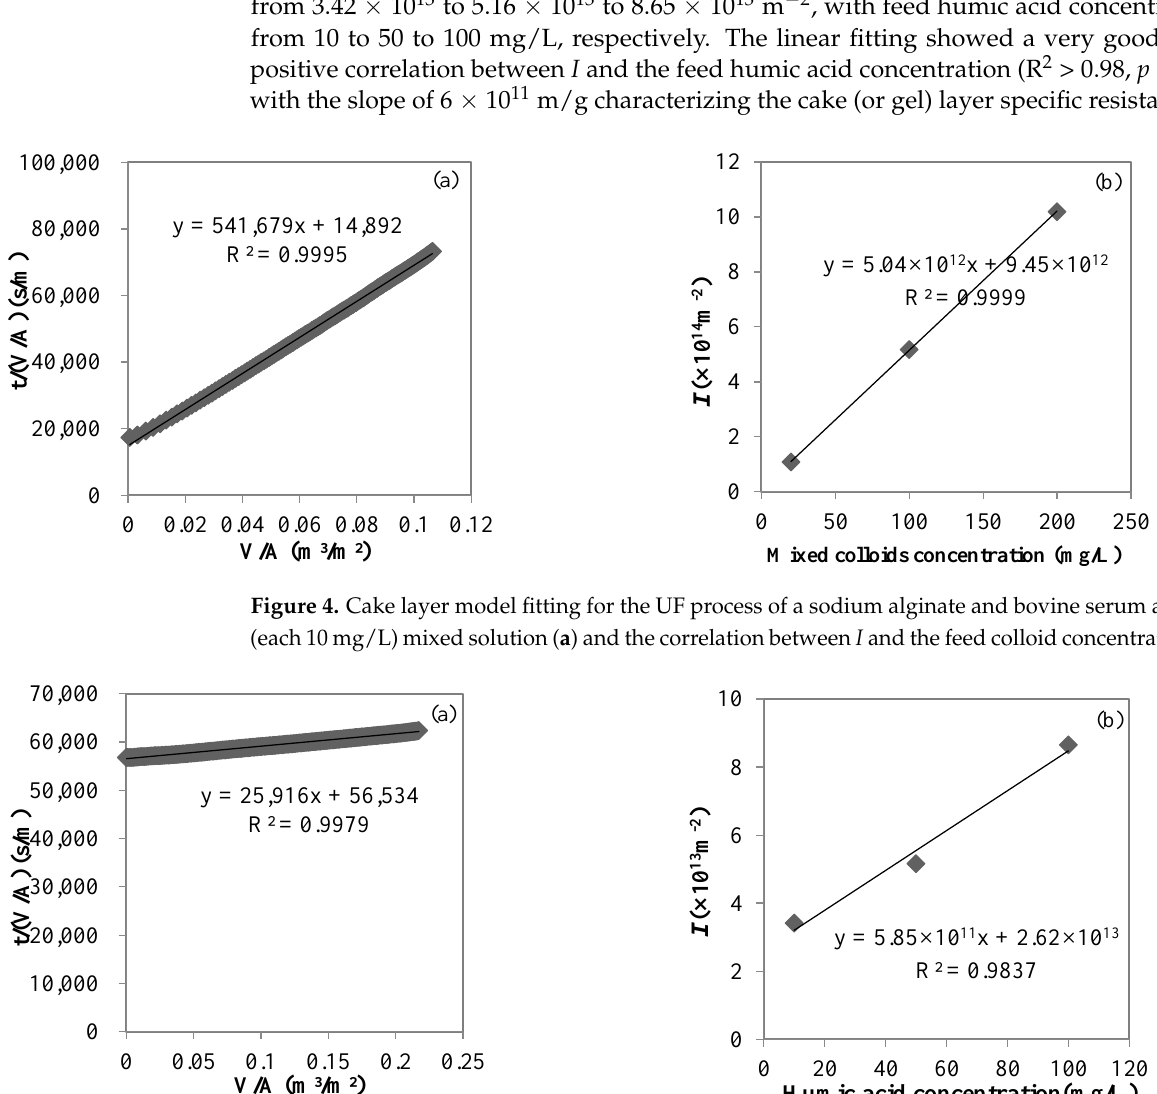
Figure 5. Cake layer model fitting for the NF process of a 10 mg/L humic acid solution ( a ) and the correlation between I and the influent humic acid concentration ( b ).